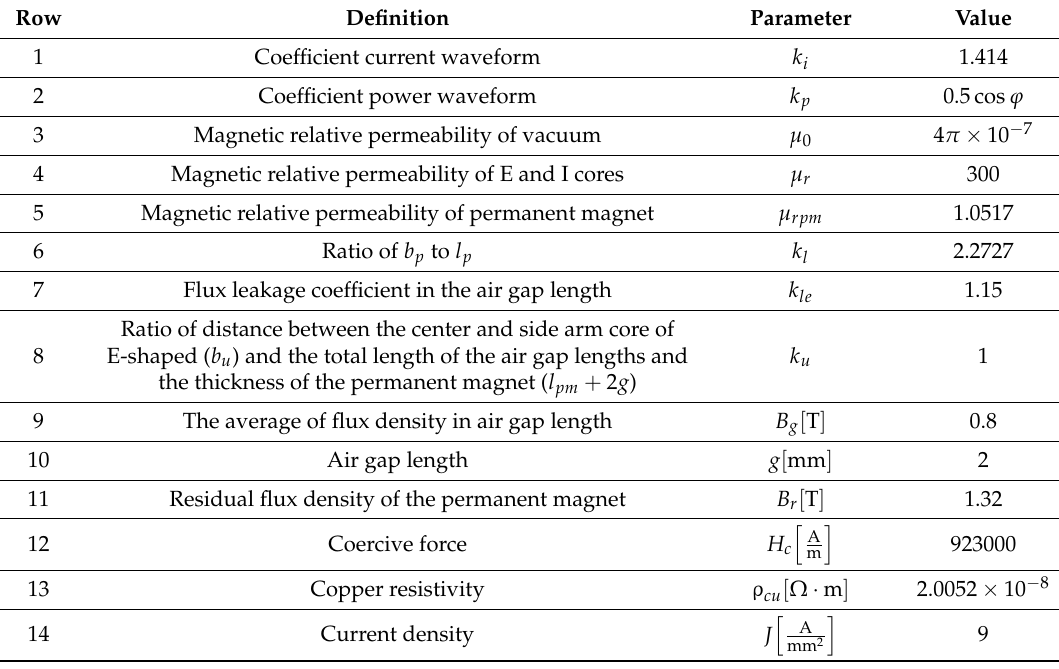
Table 3. Adoptive parameters in designing the proposed